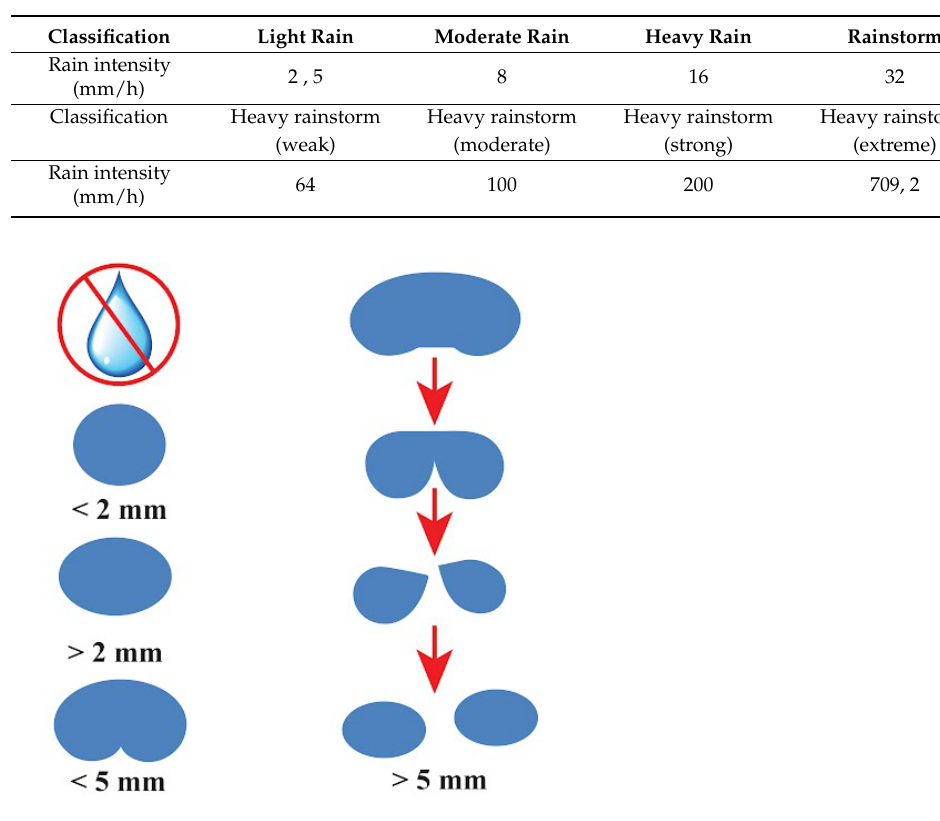
Table 2. Classification of Rain Intensity.